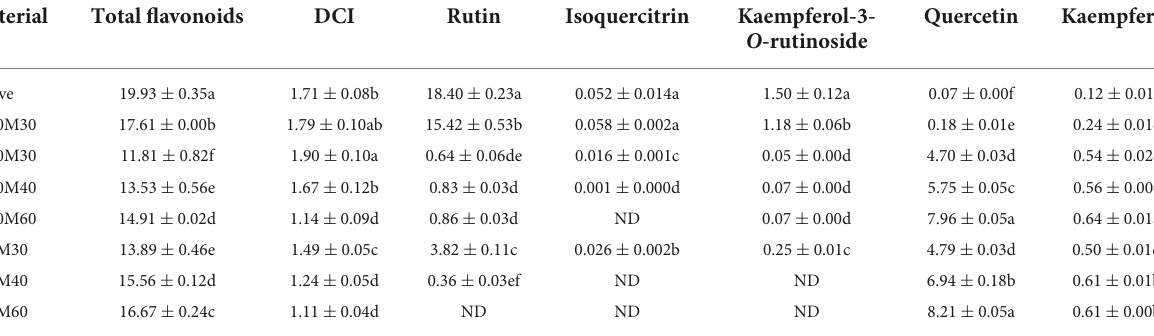
TABLE 4 Concentrations of total flavonoids, DCI, and individual flavonoids in native and pregelatinized Tartary buckwheat flour (mg/g dry